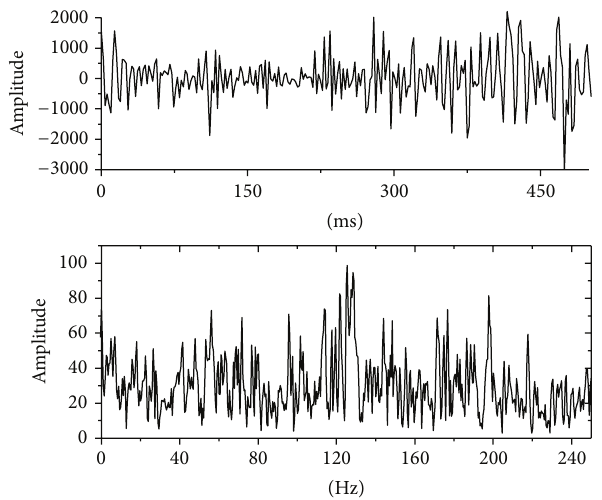
Figure 18: Roller horizontal vibration measured results after gap